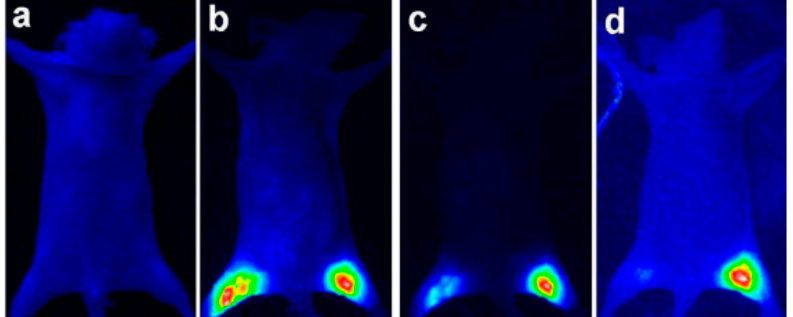
Figure 15. Multiplex near-infrared fluorescence imaging of mouse administered with two different NIR-emitting QDs-loaded micelles by subcutaneous injection (the right leg, 720 nm-emitting NCs; the left leg, 800 nm-emitting NCs): ( a ) Before injection, ( b ) λ ex = 600 nm, a 700 nm long pass filter, ( c ) λ ex = 660 nm, an 800 nm long pass filter, ( d ) λ ex = 766 nm, an 800 nm long pass filter. Reproduced with permission from [195]. Copyright American Chemical Society, 2012.